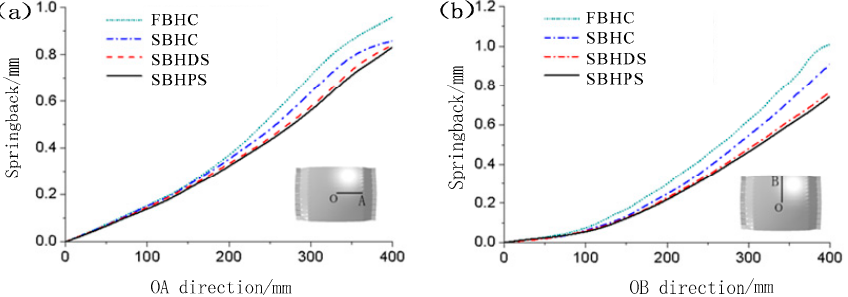
Figure 11. Springback distribution curves of the formed parts: ( a ) along OA direction; ( b ) along OB direction.